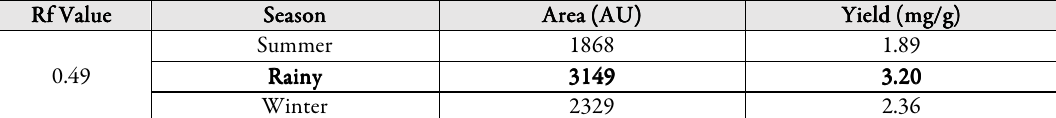
Table 5. HPTLC analysis of A. vasica leaf extract Rf Value